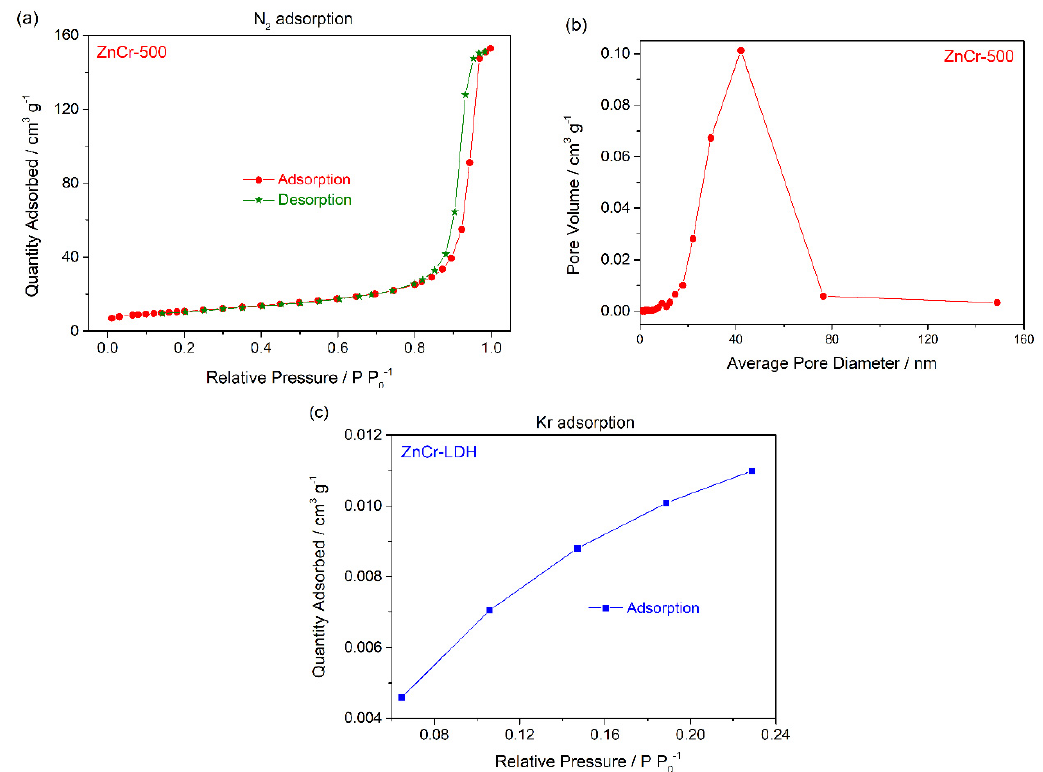
Figure 7. ( a ) N 2 adsorption-desorption isotherm; and ( b ) pore size distributions obtained for ZnCr-500 sample; ( c ) Kr adsorption isotherm for ZnCr-LDH. Table 1. Specific surface area, pore size and pore volume for ZnCr-LDH and ZnCr-500 samples.